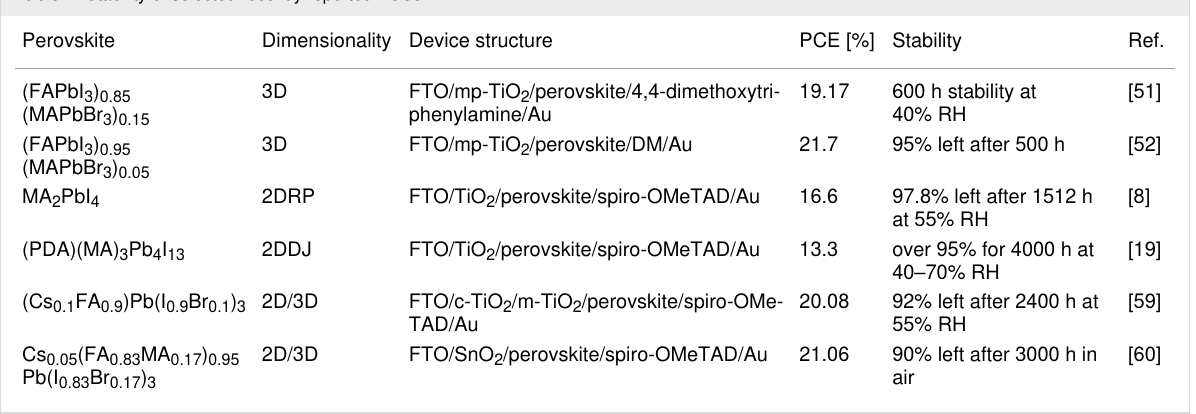
Table 2: Stability of selected recently reported PSCs.